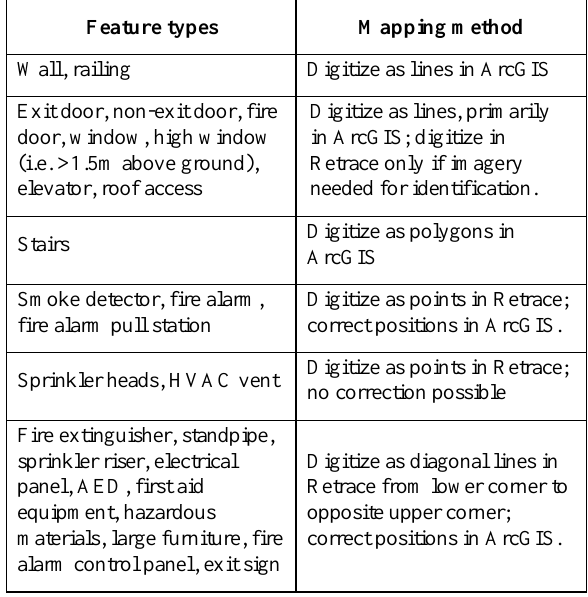
Table 1: Target feature types and mapping methods.